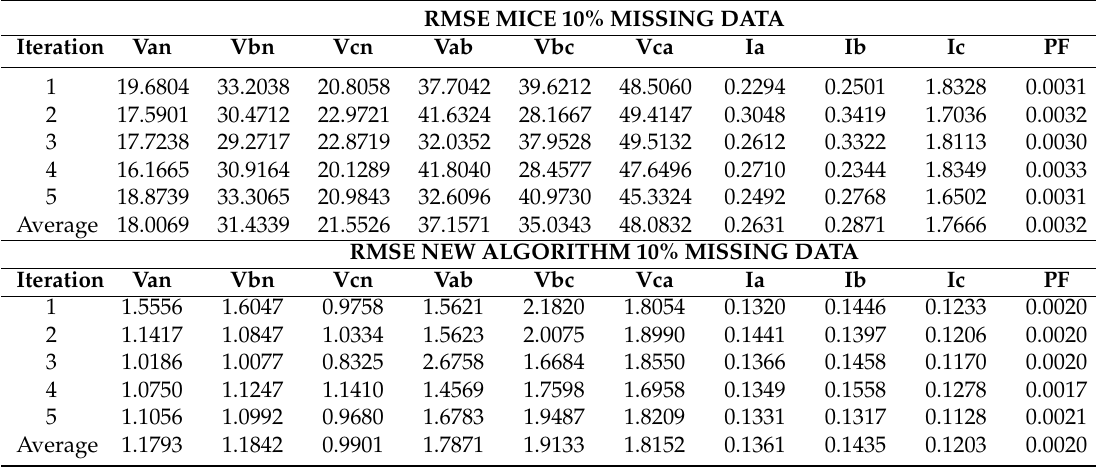
Table 4. RMSE obtained with a 10% of missing data MICE and new proposed AAA package.